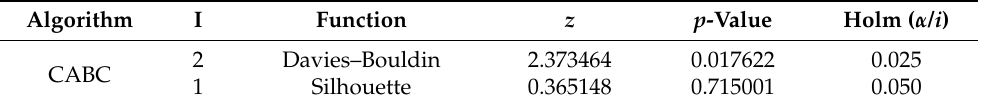
Table 6. Results of the Holm test comparing the best performed fitness function of each algorithm with respect other fitness functions, according to the ARI